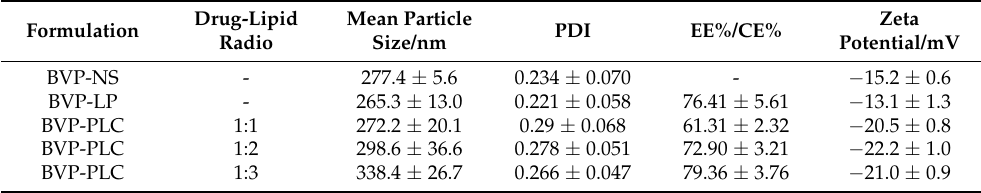
Table 2. Mean particle size, PDI, CE%, EE% and zeta potential/mV of three preparations. Drug-Lipid Formulation